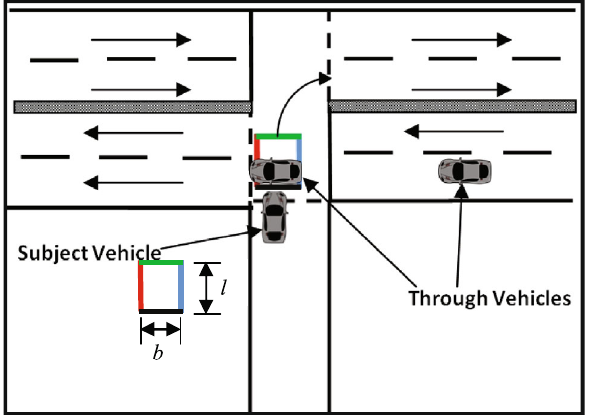
Fig. 8 Schematic representation of INAFOGA for minor road right turn